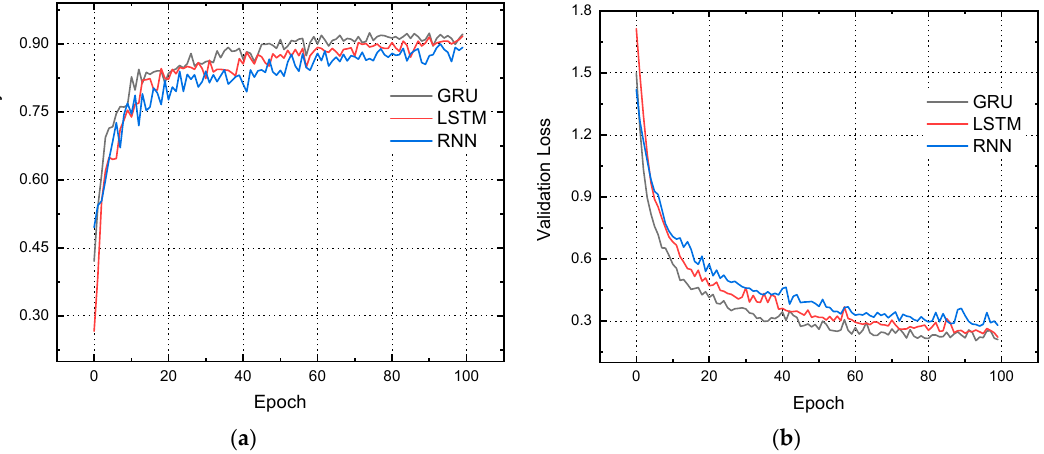
Figure 12. ( a ) Validation Accuracy of the developed models GRU, LSTM and RNN; ( b ) Validation Loss of the developed models GRU, LSTM and RNN.